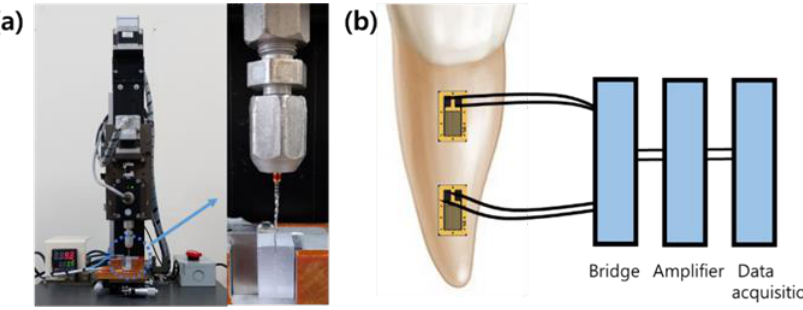
Figure 1. Experimental test set-up to measure the torque and strain ( a ) A custom-made equipment for measuring torsional resistance; ( b ) an experimental setting of attaching the strain–stress gauge to the tooth.